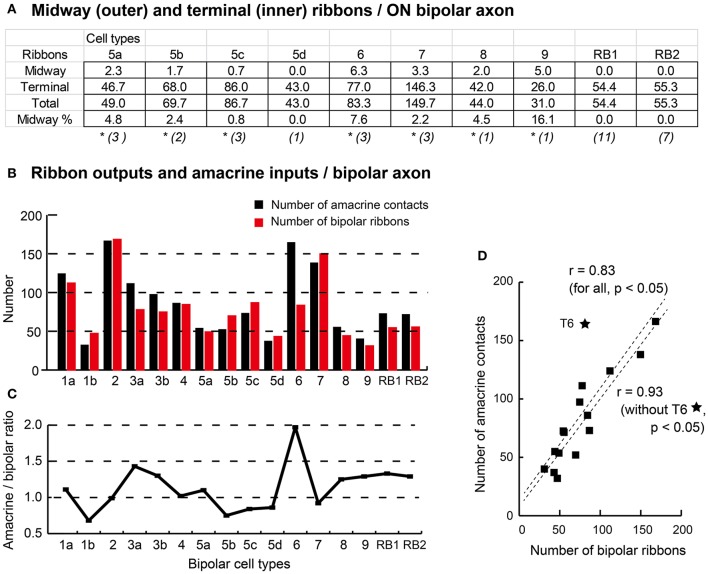
Proportion of midway and terminal ribbons (A) and correlation of amacrine input and bipolar output (B–D). (A) Summary of the ON bipolar cell type-dependent distribution of the midway ribbons in the outer (OFF) sublamina and the terminal ribbons in the inner (ON) sublamina of the IPL. Percentage (%) is derived from the outer to total ratio. The number of cells is shown in each parenthesis, and an asterisk (*) means the existence of midway ribbons. (B) A histogram of the number of input amacrine cell synaptic contacts (black) and the number of output bipolar cell synaptic ribbons (red). (C) A line chart of the ratio of amacrine cell synapses to axonal ribbons across bipolar cell types. (D) A scatter plot with regression lines showing Pearson's correlation coefficient between the number of amacrine cell synapses and the number of bipolar cell ribbons.